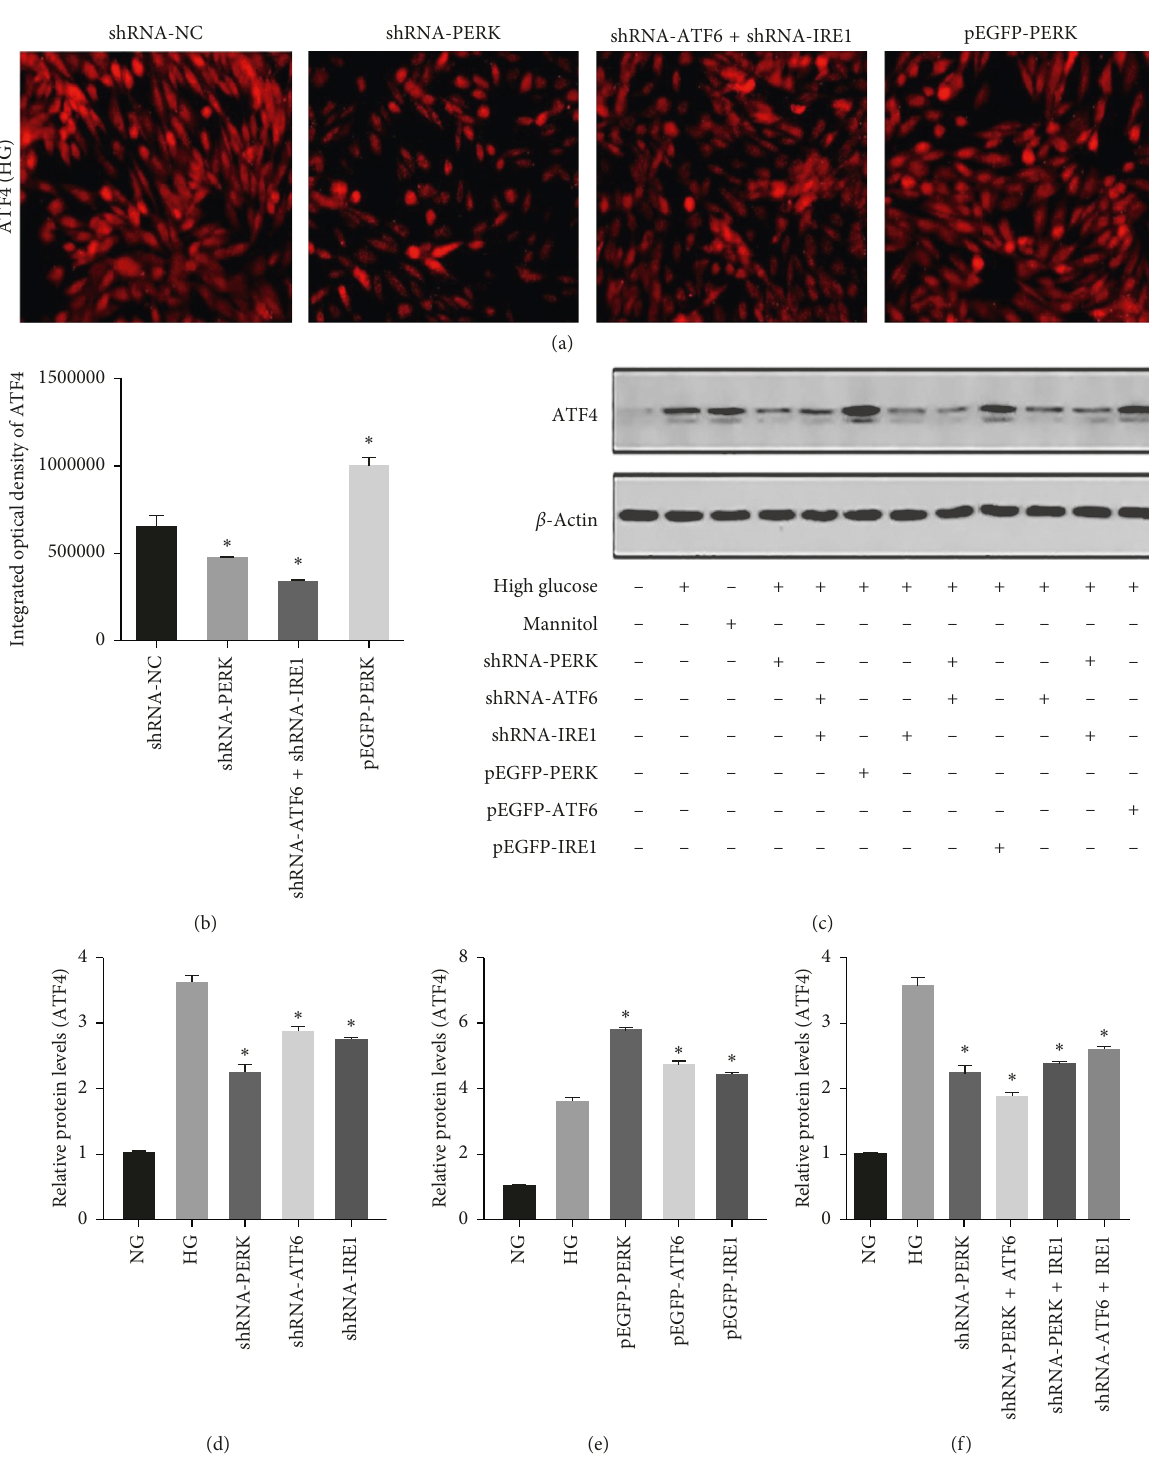
Figure 4: Immunofluorescence and immunoblotting of ATF4 in rMCs at HG. (a, b) Inhibition of UPR pathways significantly decreased ATF4 immunofluorescence. (c–f) The protein levels of ATF4 in rMCs transfected with PERK, ATF6, and IRE1 shRNAs or overexpression plasmids at HG for 48hours were measured by western blot analysis. The results were representative of 3 independent experiments ( n � 3; ∗ p < 0 .